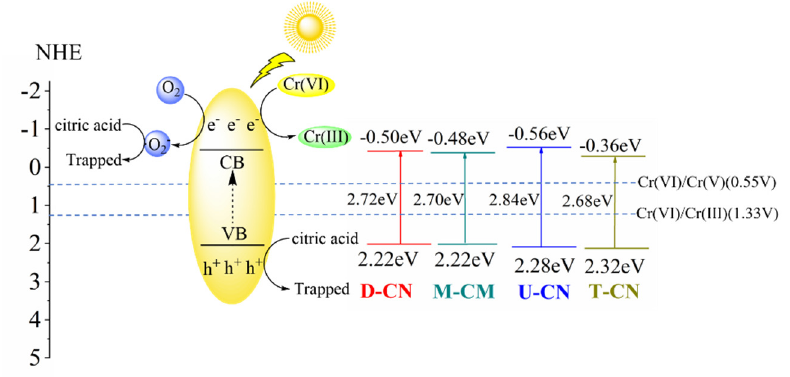
Figure 10. Proposed mechanism for photocatalytic reduction of Cr(VI) over U-CN.